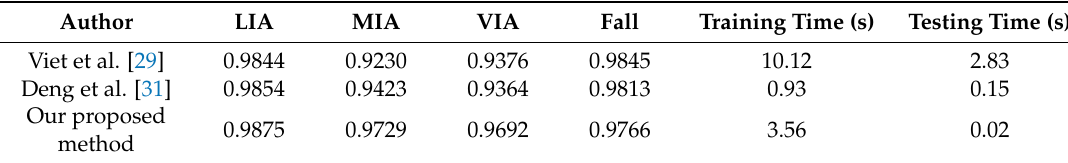
Table 6. Performance of the user-adaptive